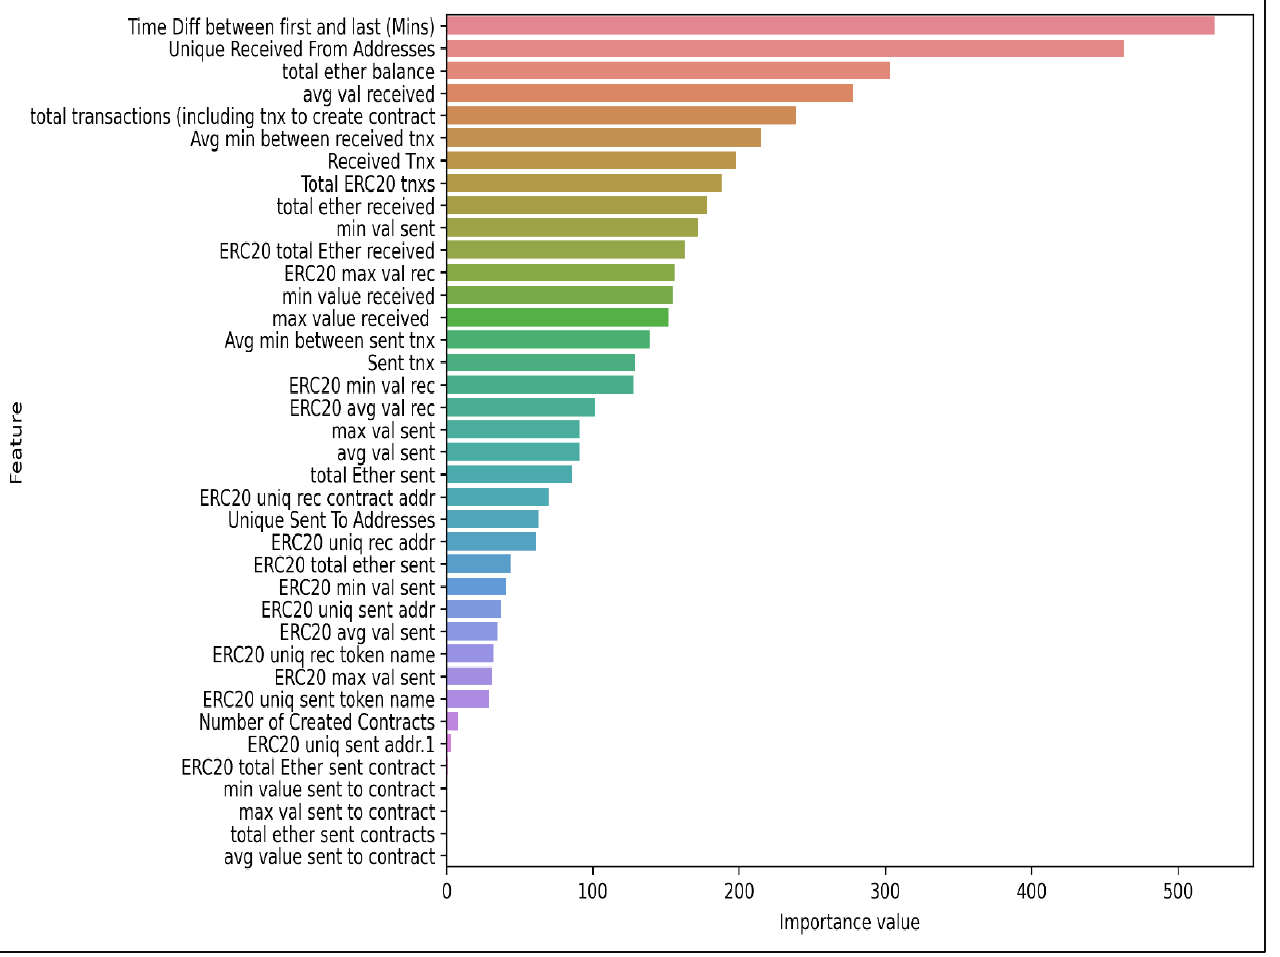
Figure 9. Feature importance